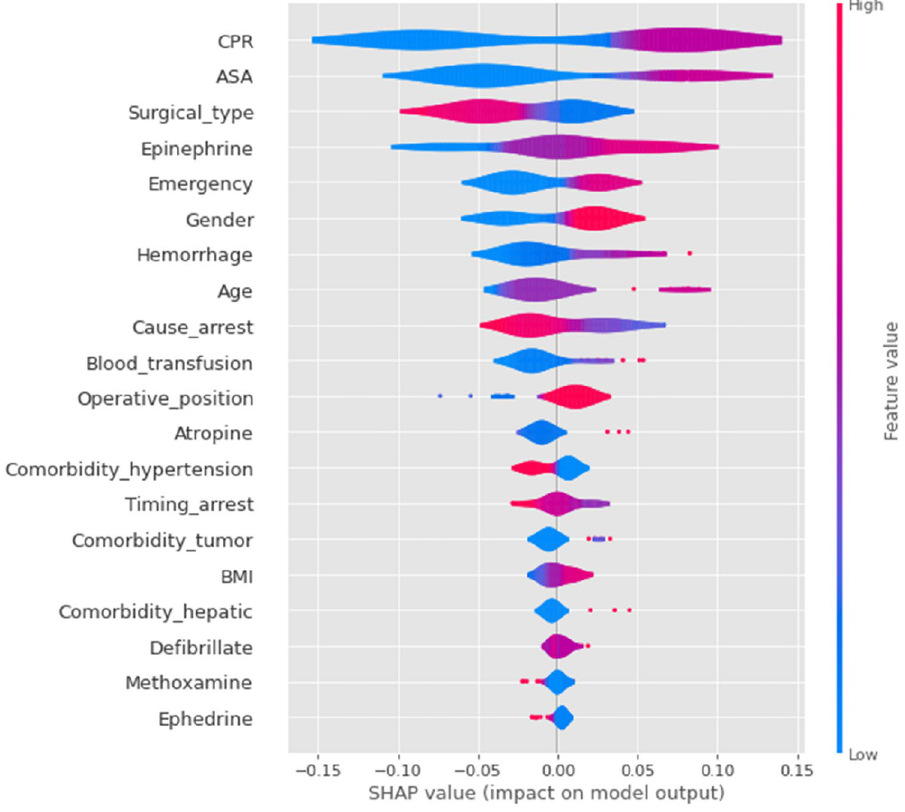
Figure 3. SHAP importance plots of the mortality and risk factors for the ensemble ML model (VotingClassifier). The features are ranked by importance. Each row represents the impact of a feature on the outcome of mortality, with higher SHAP values indicating higher likelihood of a positive outcome. For a binary feature, like gender, “male” → “1” is shown in red while “female” → “0” is shown in blue. For the detailed mapping of categorical features, please refer to the code online (such as “ < 12 ys” → “0”, “12 ~ 40 ys” → “1”, “40 ~ 65 ys” → “2”, “ > 65 ys” →